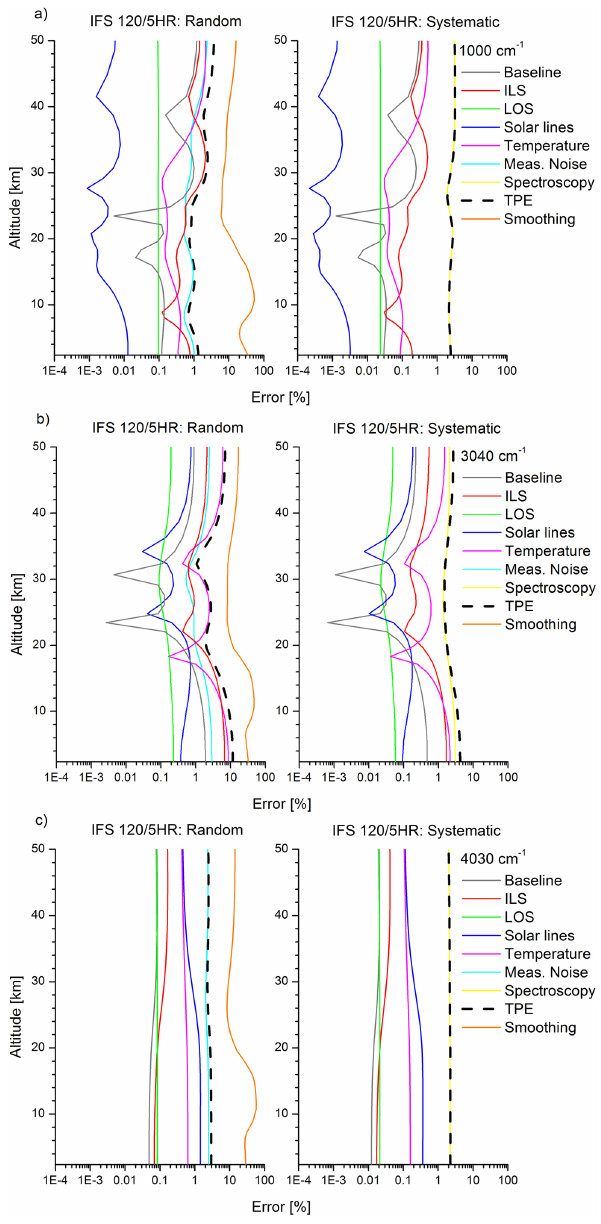
Figure A1. Random and systematic error profiles [%] for typical measurement conditions of Izaña spectrometer 120 / 5HR (25 Octo- ber 2010) for the spectral regions: 1000cm − 1 (a) , 3040cm − 1 (b) , and 4030cm − 1 (c) . ILS means the joint error due to the modulation efficiency amplitude and phase error uncertainties and TPE (total parameter error, black line) is the quadratic sum of all errors except for smoothing